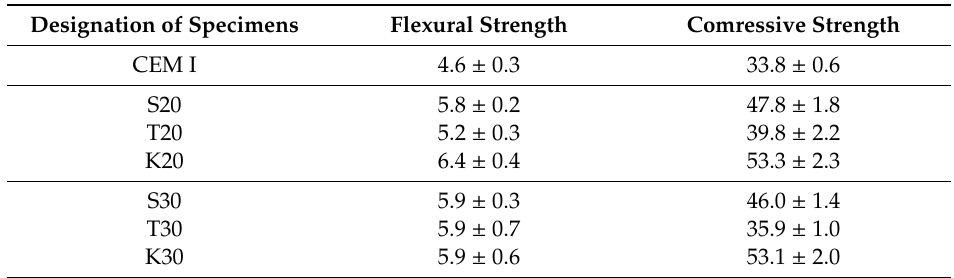
Table 5. The results of compressive and flexural strength of pastes stored in water in 20 ± 2 °C after 28 days of curing (MPa).